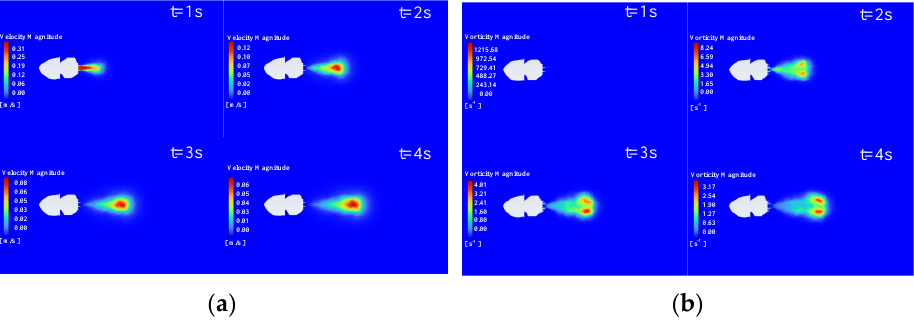
( b ) Figure 12. Flow field variation during jetting of the bionic jellyfish robot with 25 mm diameter noz- zle ( a ) velocity nephograms at different moments; ( b ) vorticity maps at different moments. The pressure at the nozzle is integrated to obtain the time-varying curve of the thrust force at different nozzle diameters (Figure 13). Figure 13. Time variation curve of thrust forces with different nozzle diameters. From the Figure 13, it can be concluded that the thrust force produced by different nozzles increases rapidly to a maximum value and decreases slowly to 0. As the nozzle